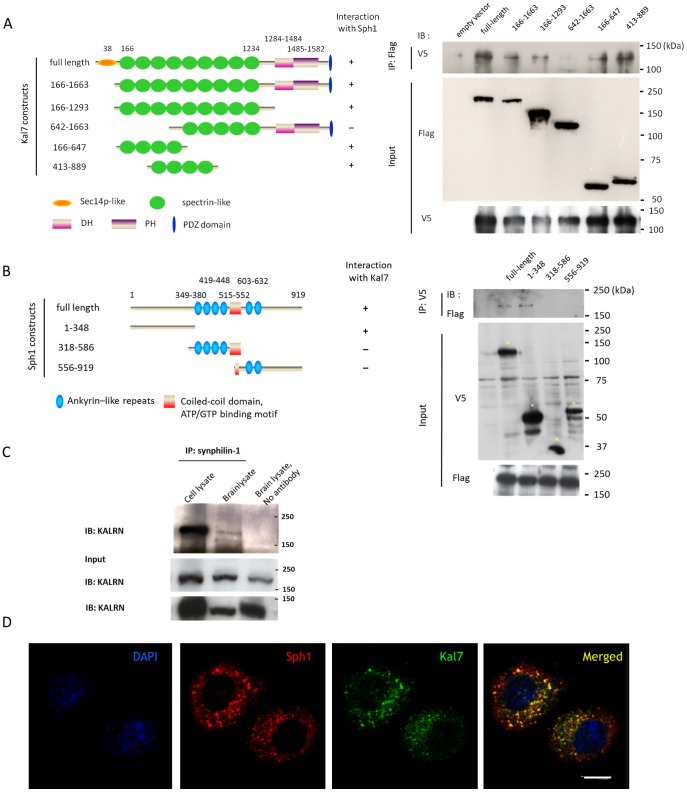
Kalirin-7 interacts with synphilin-1 in vitro and in vivo.(A) Mapping of the interacting domain in the kalirin-7 protein. FLAG-kalirin-7 constructs as shown in the diagram were co-transfected with V5-synphilin-1 in HEK293 cells. 24 h after transfection, cells were subjected to immunoprecipitation with anti-FLAG agarose beads and subsequently kalirin-7 and synphilin-1 immunoreactivities were monitored applying anti-FLAG- or anti-V5 antibodies, respectively. IP indicates antibodies used for pulling down target proteins. IB indicates antibodies used for detection in western blot. The figure shows that kalirin-7 co-immunopreciptates with synphilin-1 and that spectrin repeats III and IV of the kalirin-7 protein are crucial for the interaction. Quantification of kalirin-7 fragment expression is shown in Figure S3. (B) Mapping of the binding region in synphilin-1. The indicated V5-synphilin-1 constructs were co-transfected with FLAG-kalirin-7. Synphilin-1 fragments were precipitated with anti-V5 antibodies. The precipitates were then probed with anti-FLAG antibodies to detect co-precipitated kalirin-7. The deletion mapping revealed that amino acids 1–348 of the synphilin-1 protein are crucial for the binding of kalirin-7. The asterisks indicate specific input signals of synphilin-1 fragments. For quantification of synphilin-1 fragment expression please refer to Figure S3. (C) Endogenous synphilin-1 interacts with kalirin-7. Synphilin-1 was precipitated from whole-brain tissues (500 µg) of a wild type mouse with an anti-synphilin-1 antibody (Sigma). The precipitates were probed with a kalirin-7-specific antibody (KALRN from Abcam). Cell lysate of HEK293 cells overexpressed with FLAG-kalirin-7 and V5-synphilin-1 served as positive control. As a negative control brain lysate was subjected to immunoprecipitation without antibody. (D) Overlapping localization of kalirin-7 and synphilin-1 in cell culture. HEK293 cells were transiently transfected with both constructs for 6 h and stained with anti-FLAG and anti-V5 antibodies. The counterstaining was done with YoPro dye. The confocal sections demonstrate that both proteins display a punctate staining in the cytoplasm. Sph1, synphilin-1; Kal7, kalirin-7. Scale bar, 10 µm.